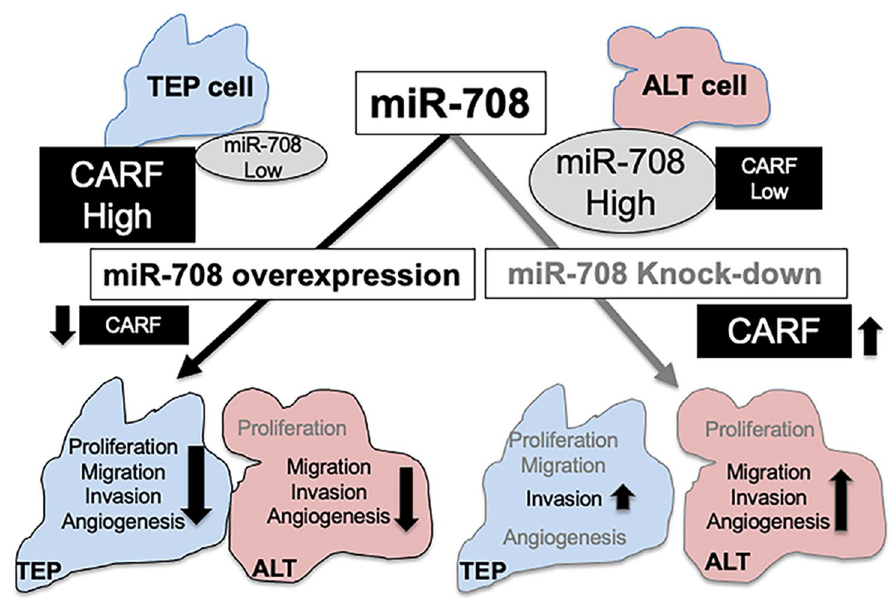
Figure 8. Schematic presentation of differential expression of miR-708 and its target CARF that evokes differential regulation of cell proliferation in TEP and ALT